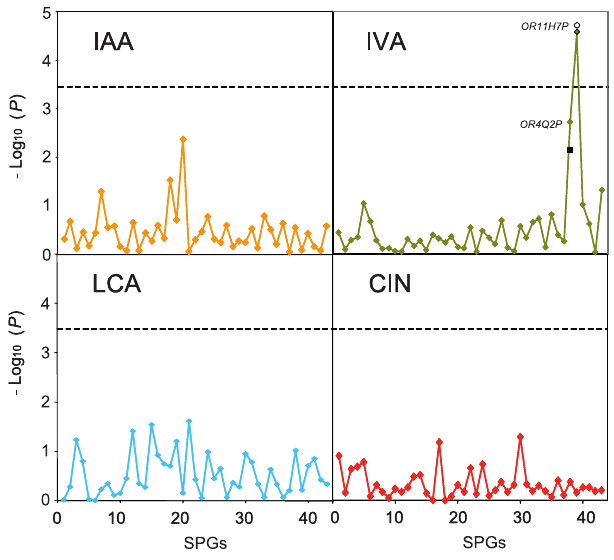
Figure 2. Genotype–Phenotype Association ANOVA p -values for comparison between the olfactory threshold distributions of participants with homozygous disrupted genotypes versus heterozygous and homozygous intact genotypes (1 df), using ‘‘ gender ’’ and ‘‘ gender by genotype ’’ as covariates. SPG loci are enumerated as in Table S2. The broken line indicates the statistically significant value of p ¼ 0.05 after Bonferroni correction for 172 tests (four odorants 3 43 SPGs). The two strongest p -values for IVA are for the genes marked in Figure 3. Using the individual’s average threshold towards the four odorants as an additional covariate did not change the association signal with OR11H7P (open circle in IVA panel). The association signal with OR4Q2P is reduced after adjusting for the OR11H7P effect (solid square in IVA panel).